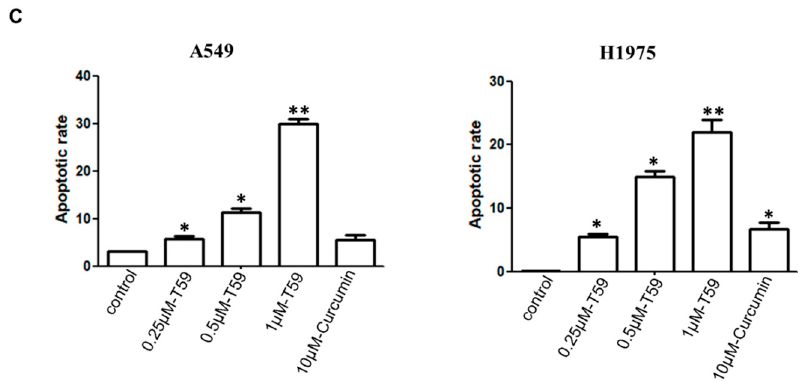
Figure 2. T59-induced apoptosis of A549. ( A ) Fluorescent micrographs ( × 400) of acridine orange (AO) stained A549 cells after treatment with 0.250 µ M, 0.500 µ M, and 1.000 µ M T59 and with 10.000 µ M curcumin for 24 h. Early apoptosis features arose after treatment with 0.500 µ M T59 for 24 h. VI: viable cells; BL: blebbing of the cell membrane; CC: chromatin condensation; EA: early apoptosis. ( B ) A549 and H1975 were stained with Annexin V-FITC and PI and analyzed by flow cytometry after treatment with 0.250 µ M, 0.500 µ M, and 1.000 µ M T59 and with 10.000 µ M curcumin for 24 h. ( C ) Histogram showing the statistical apoptosis rate of the three independent experiments in ( B ). Apoptosis rate = Q2 + Q3. * p < 0.050 stands for statistical significance.